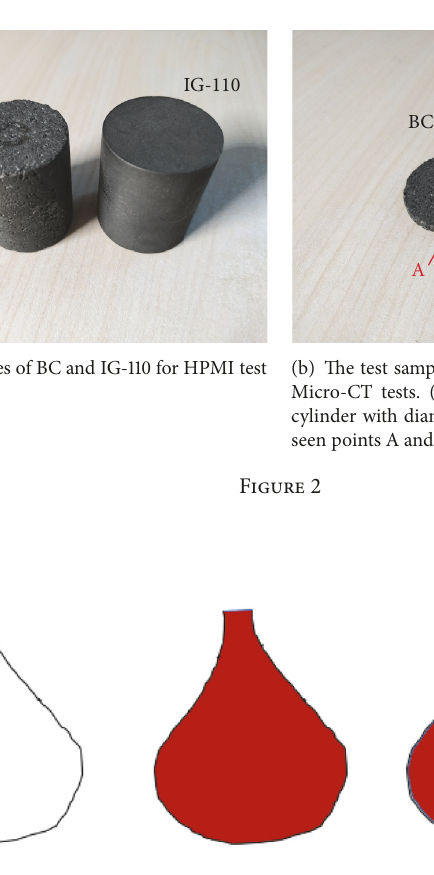
computer tomography) detection (Figure 2(b), point A and